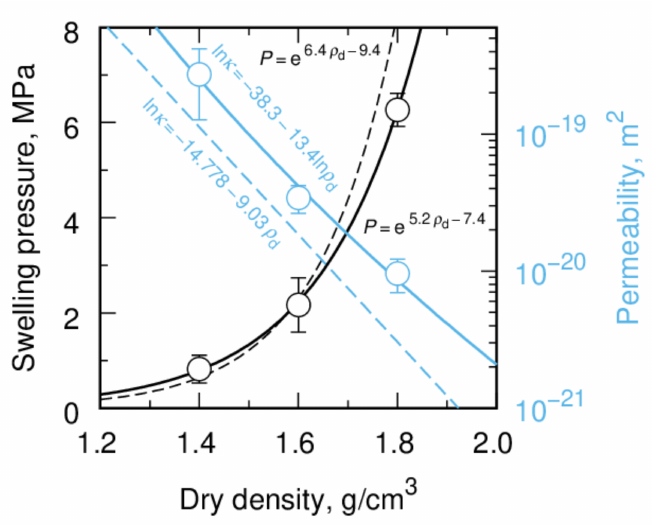
Figure 6. Swelling pressure and permeability (m 2 ) of 10X specimens permeated by SGW as a function of dry density ρ d . Circles and solid lines represent measured values and fitted curves of the present study, whereas dashed lines represent fitted curves of the study [4] (hydraulic conductivities reported in [4] were converted to permeabilities for the purpose of